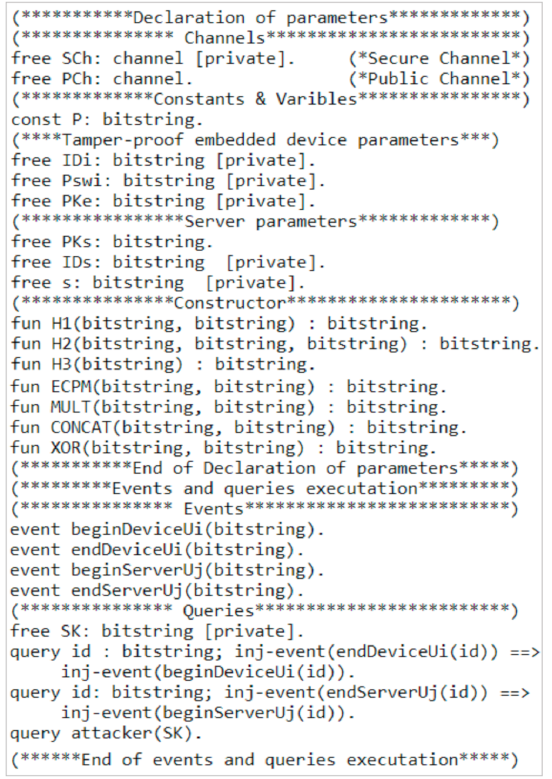
Figure 8. Declaration of parameters, with event and query